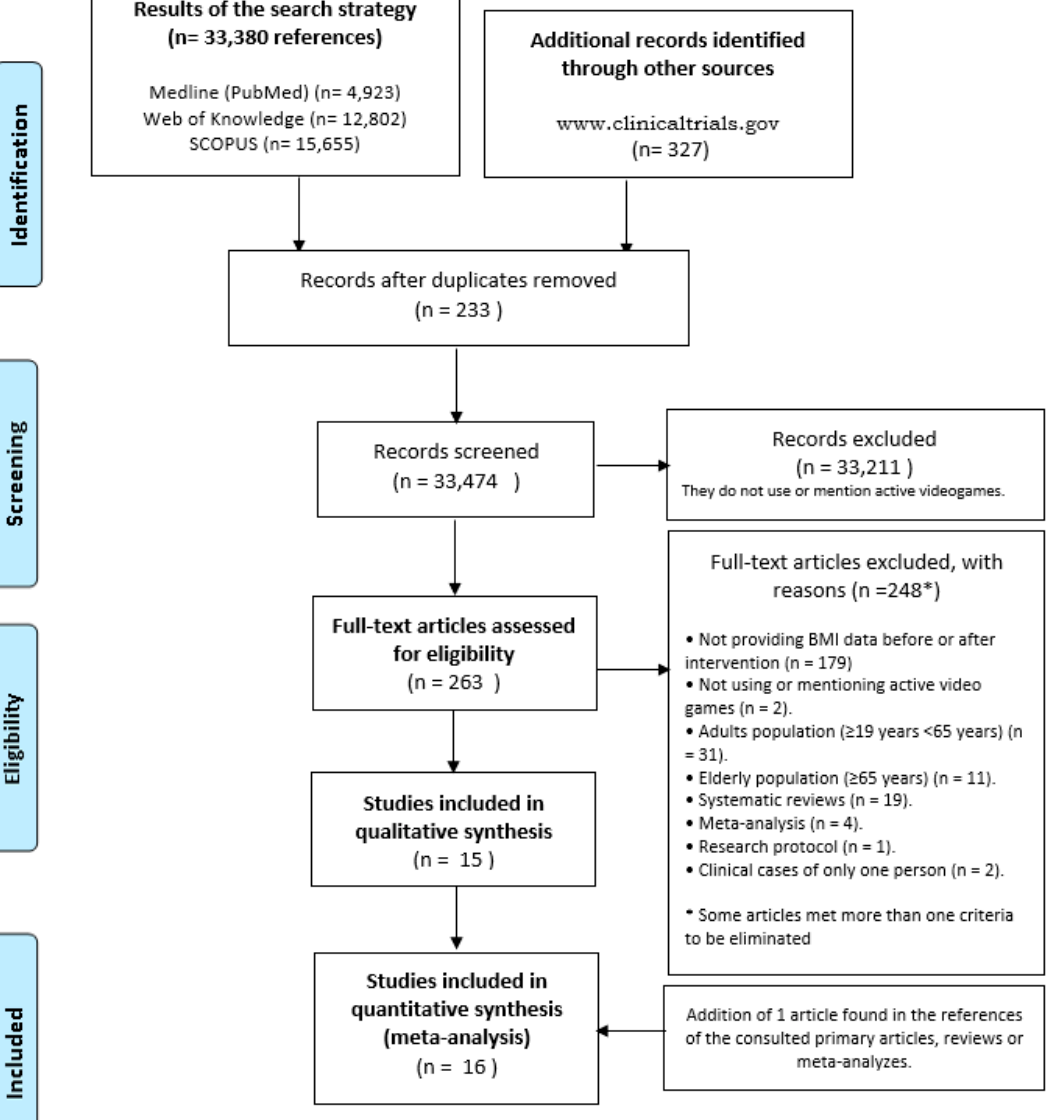
Figure 1. PRISMA 2009 Flow Diagram. Diagram of identification of clinical trials studies whose intervention was based on active video games, and its variable result was measured in BMI (Kg/m 2 , Zscore or percentile). 1 January 2000 to 13 April 2018.